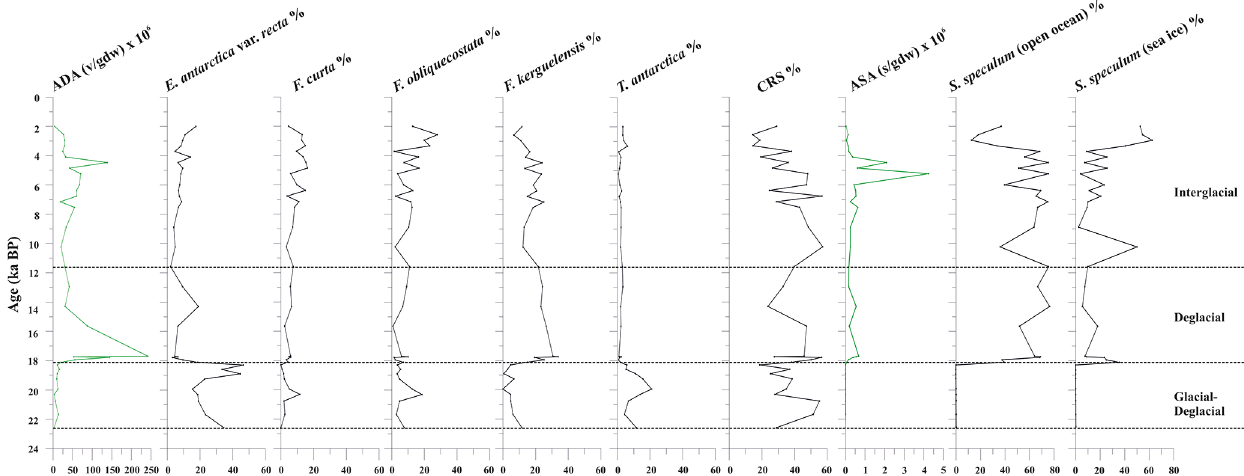
Figure 5. From left to right: absolute diatom abundance (ADA), down-core distribution of diatoms (%), absolute silicoflagellate abundance (ASA), and down-core distribution of Stephanocha speculum varieties. S. speculum (open ocean) includes S. speculum var. monospicata , var. bispicata , and var. speculum, while S. speculum (sea ice) includes S. speculum var. coronata . The top level of this core dates to 2.0ka.